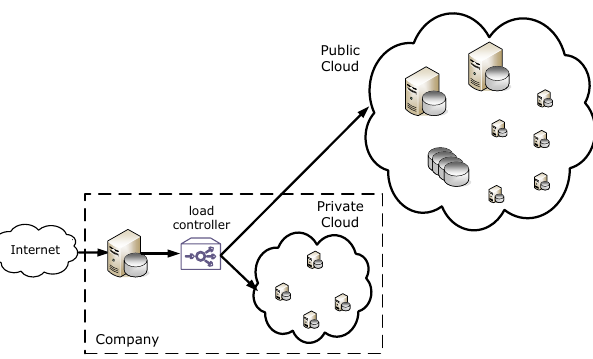
Figure 13. The hybrid cloud scenario considered.